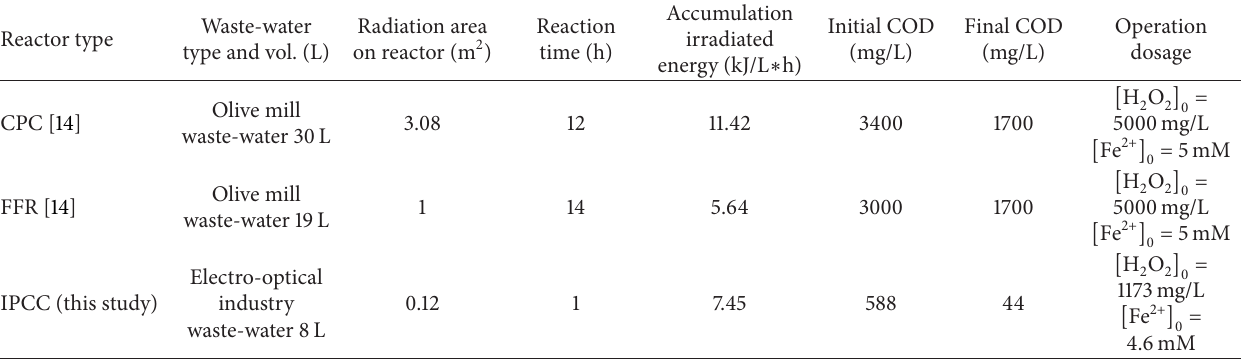
Table 5: Comparisons of operation performance for compound parabolic collecting reactor (CPC), falling film reactor (FFR), and inclined plate curvature channel (IPCC)